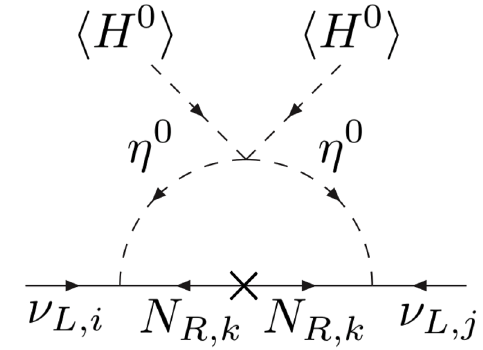
Figure 1 . One-loop radiative Majorana neutrino mass in the scotogenic model proposed in ref.